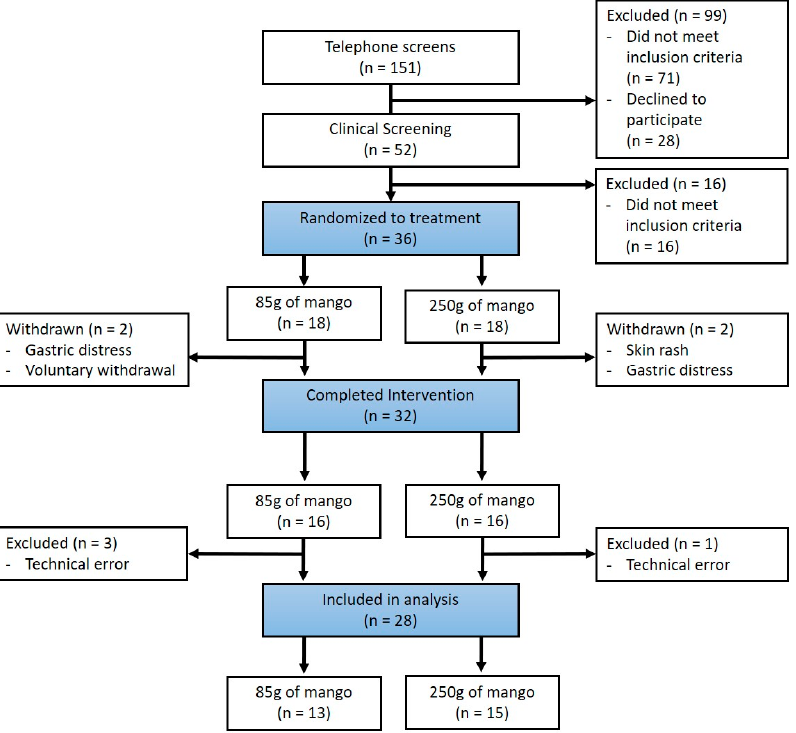
Figure 2. CONSORT flow